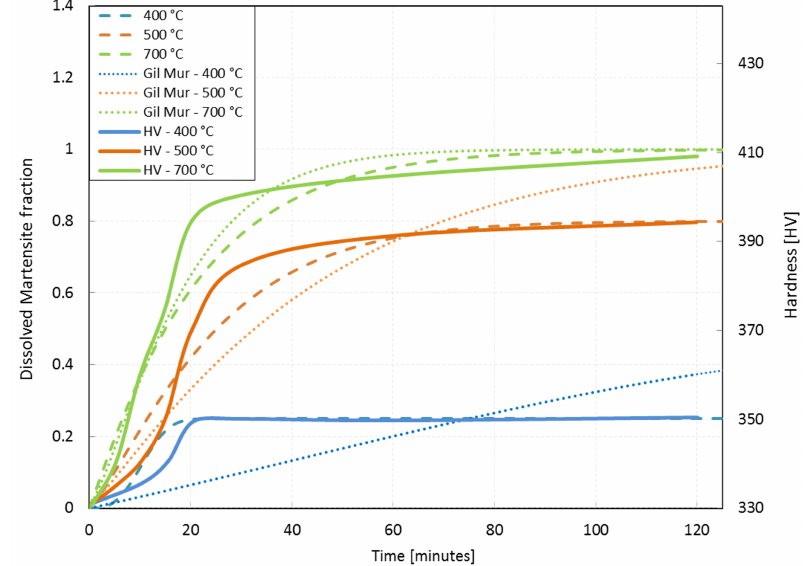
Figure 8. Experimental data of hardness evolution during isothermal treatments by Gil Mur [20] (continuous line) and fraction evolution of dissolved martensite during isothermal treatments calculated using the present model (dashed line) and using JMAK equations with parameters k, p reported by Gil Mur. Table 3. Dissolved martensite fraction at equilibrium and initial and final times ti ( T ), tf ( T ) of